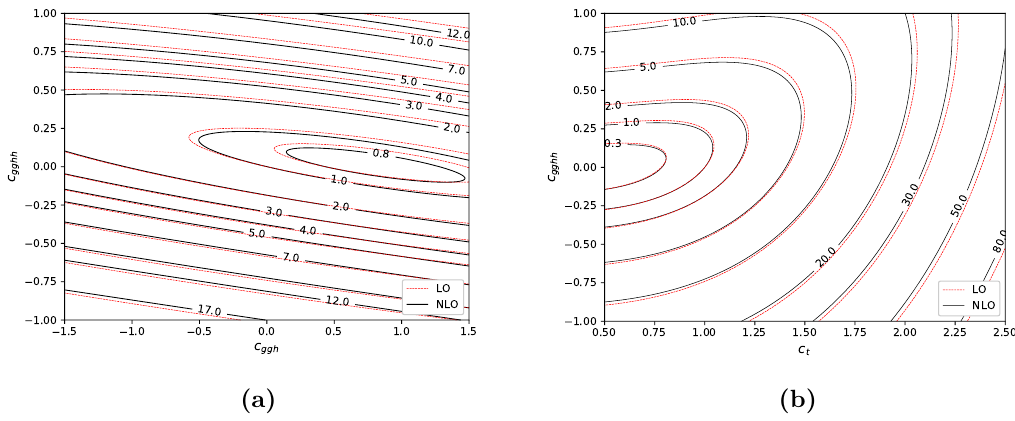
Figure 10. Iso-contours of (cid:27)=(cid:27) SM : (a) c gghh versus c ggh and (b) c gghh versus c t .